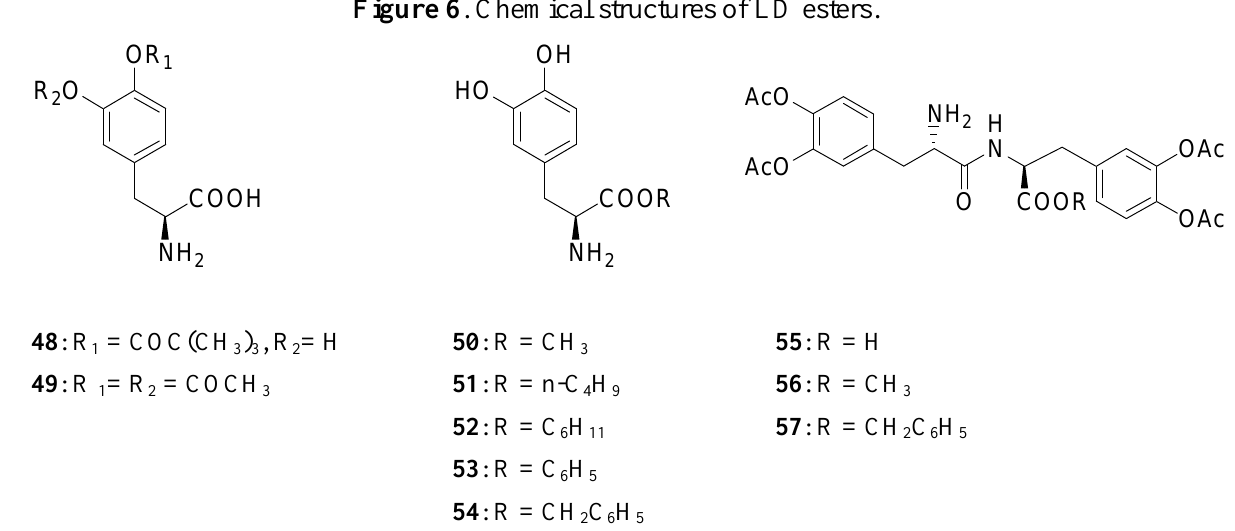
Figure 6 . Chemical structures of LD esters.